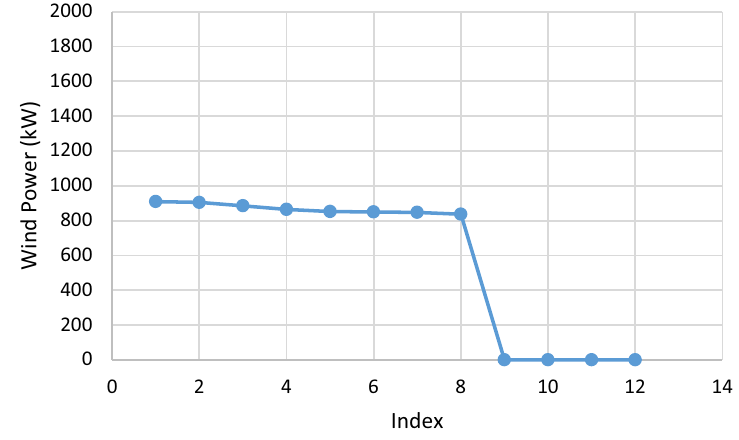
Fig. 31 Estimated wind